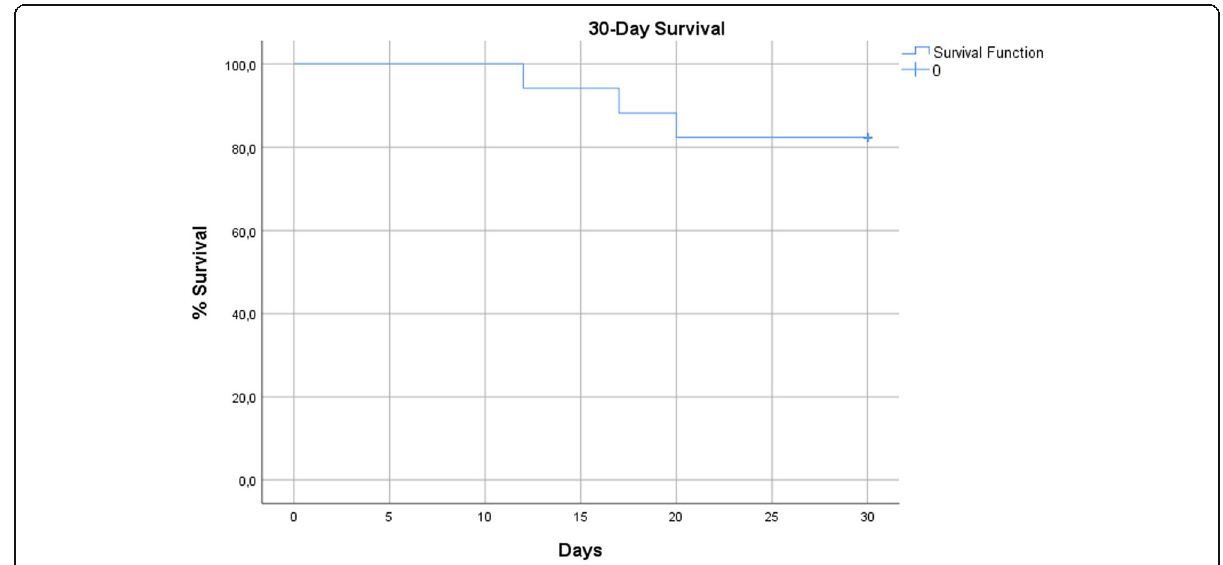
Fig. 3 Kaplan-Meier plot of 30-day survival